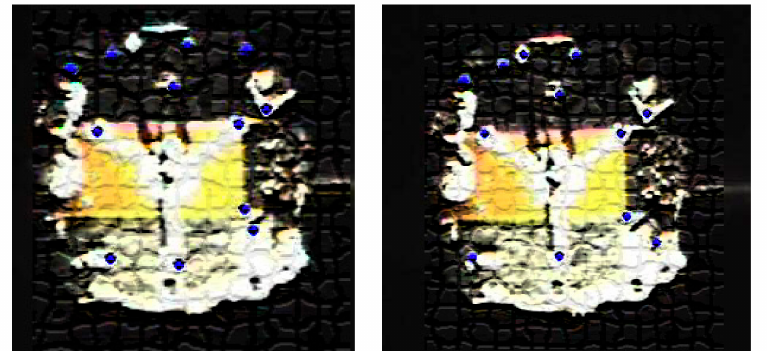
Figure 3. The feature points that are detected and matched by using feature clustering when the chaser approaches the target (The picture is